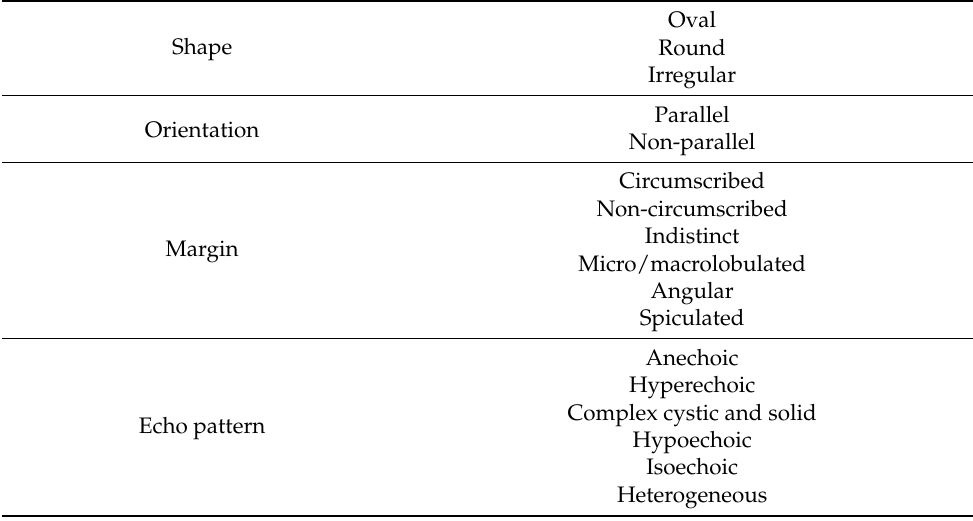
Table 2. Analyzed features of US